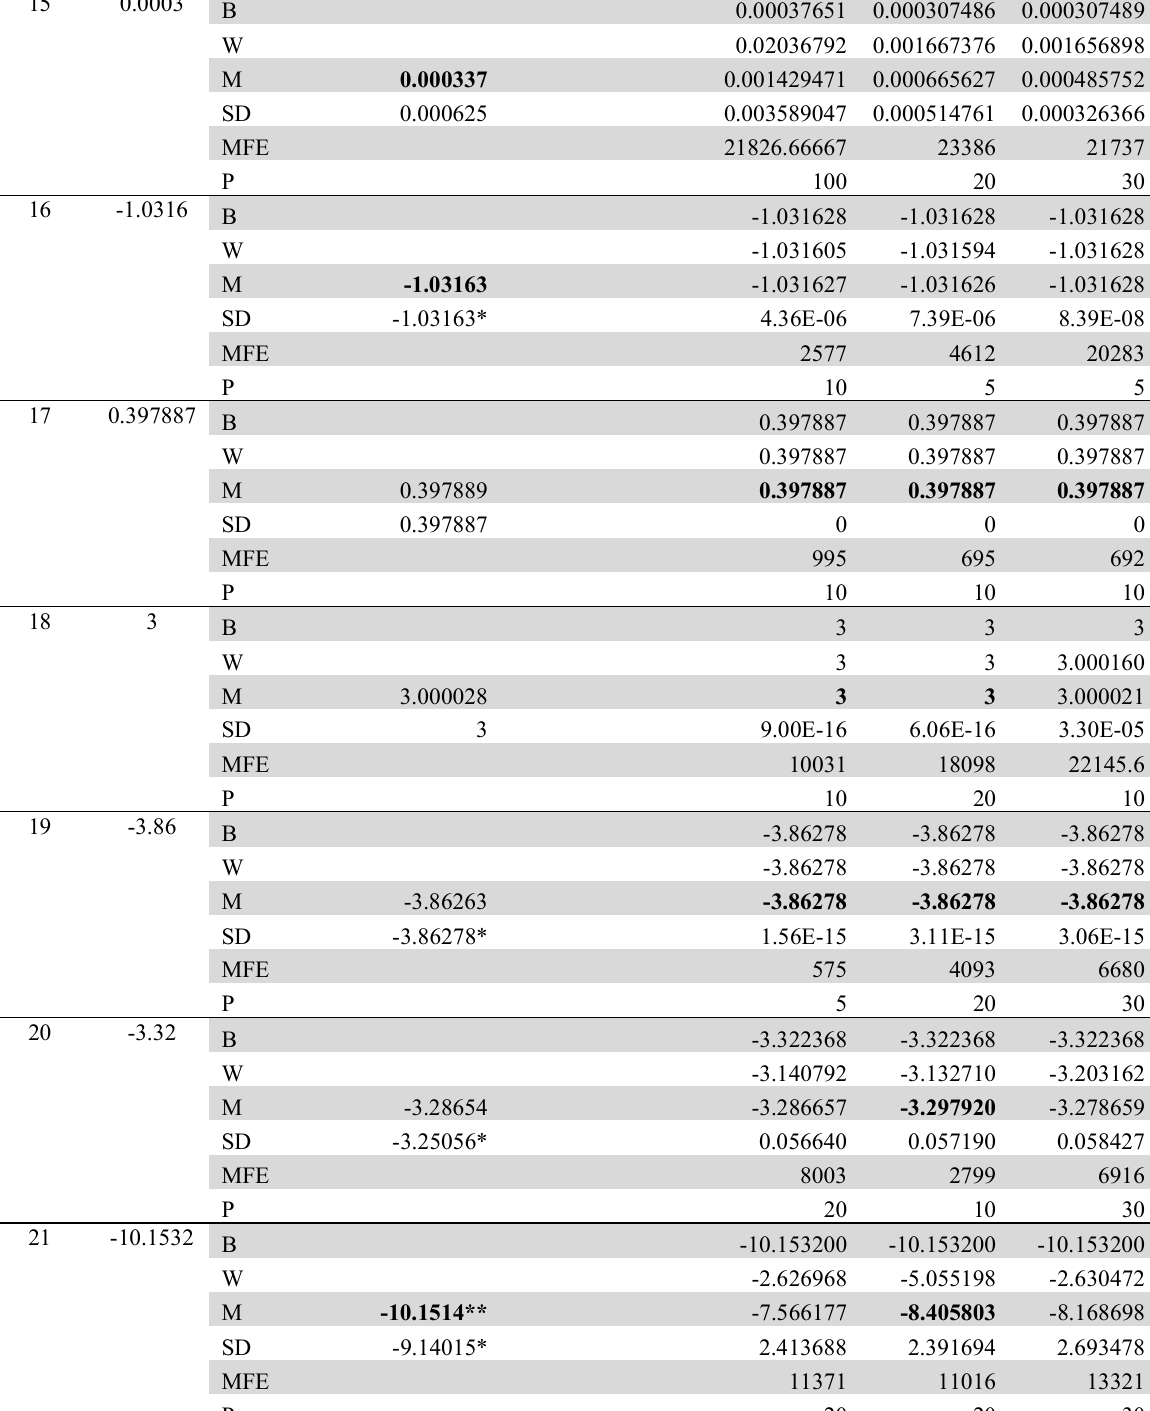
Results of the proposed algorithms for 23 benchmark functions considered (30000 function